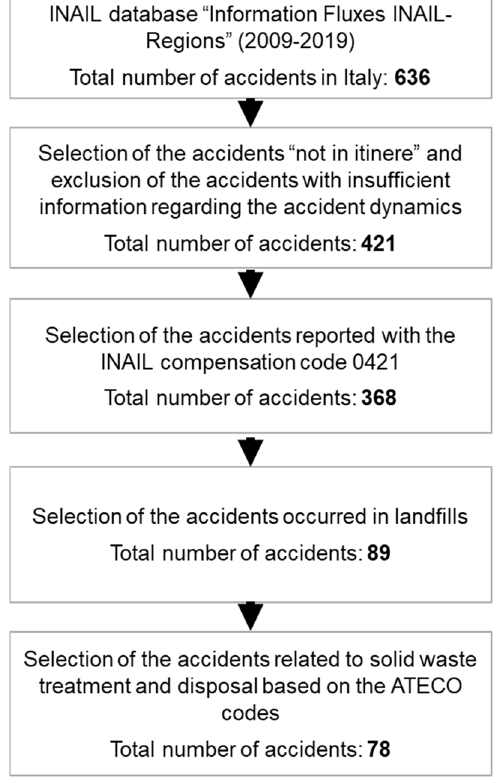
Figure 1. Scheme of the data filtering process. Table 6. Variables related to “Material agent” factors and physical activity.